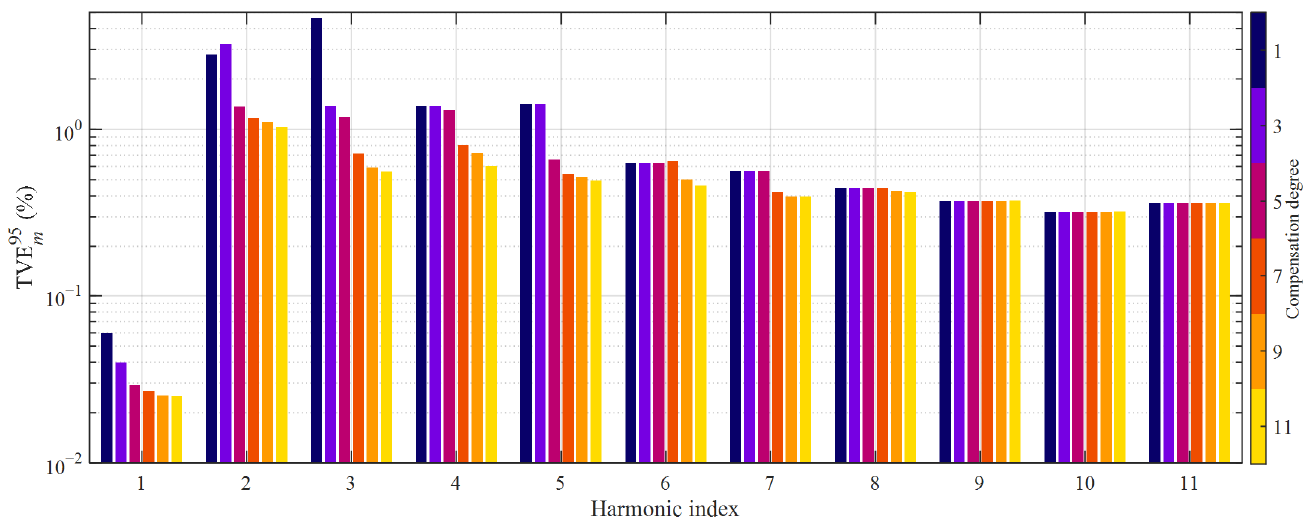
Figure 11. 95th percentile values of TVE achieved with HD compensation degrees from 1 to 11; transformer CT2, class E 2 of primary current waveforms.